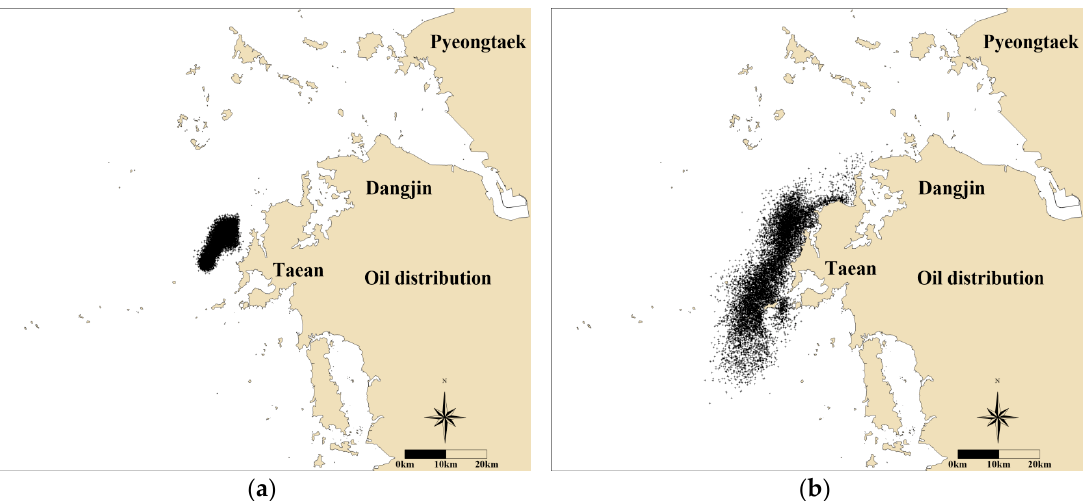
Figure 17. Oil distribution considering tidal current and wind conditions: at 8 p.m., on 7 December 2007, ( a ) 13 h after the accident; ( b ) at 11 a.m., on 11 December 2007 (right).